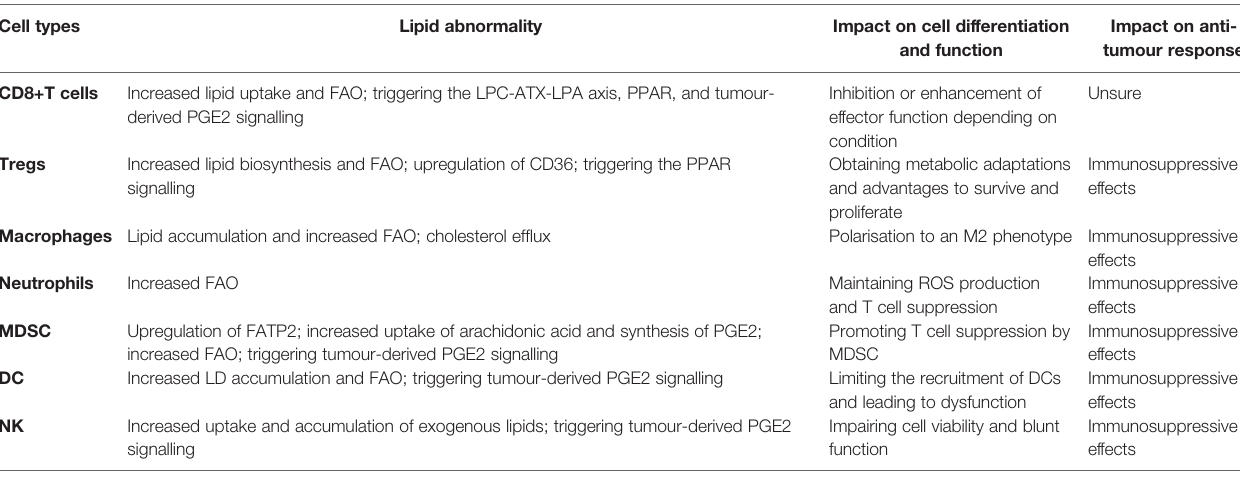
TABLE 1 | Impact of lipid metabolism and signalling on the tumour immune